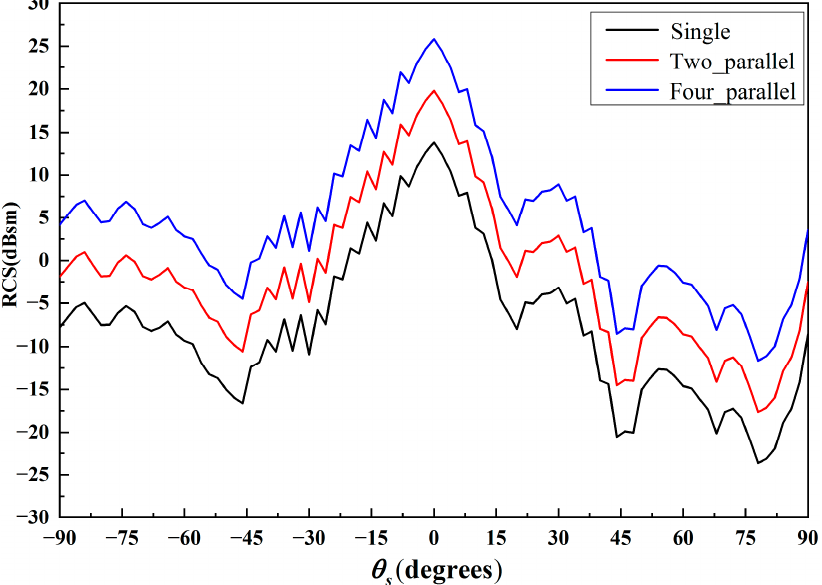
Figure 8. Mono-static RCS for HH polarization of hybrid dielectric and conductor missile-like targets with different numbers in free space.